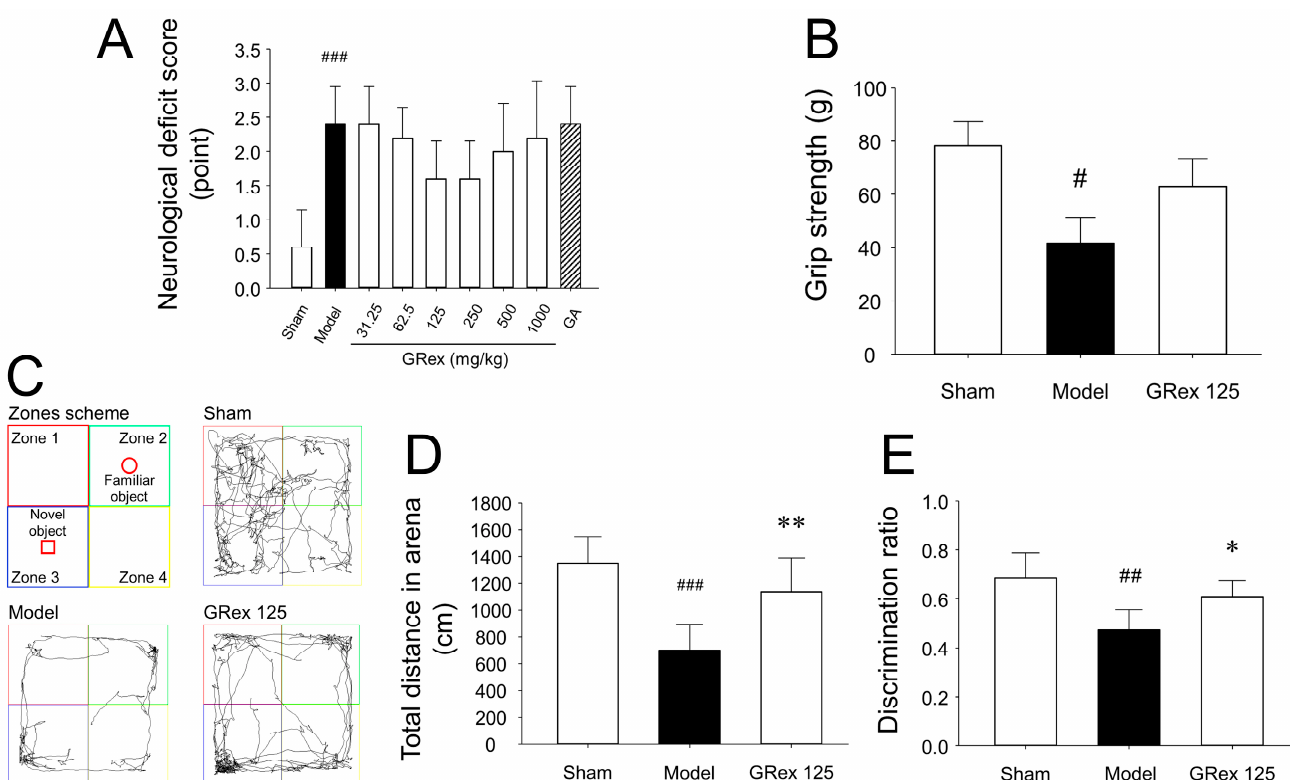
Figure 4. Measurements of neurological deficit scores (NDS), grip strength, and novel object recognition test (NORT): ( A ) NDS; ( B ) forepaw grip strength; ( C ) schematic view of NORT and the route taken by experimental mice; ( D ) spontaneous active movement during NORT; ( E ) discrimination ratio (DR). All data are expressed as mean ± SD ( n = 5). # p < 0.05, ## p < 0.01, and ### p < 0.001 compared to sham group and * p < 0.05 and ** p < 0.01 compared to MCAO model group.